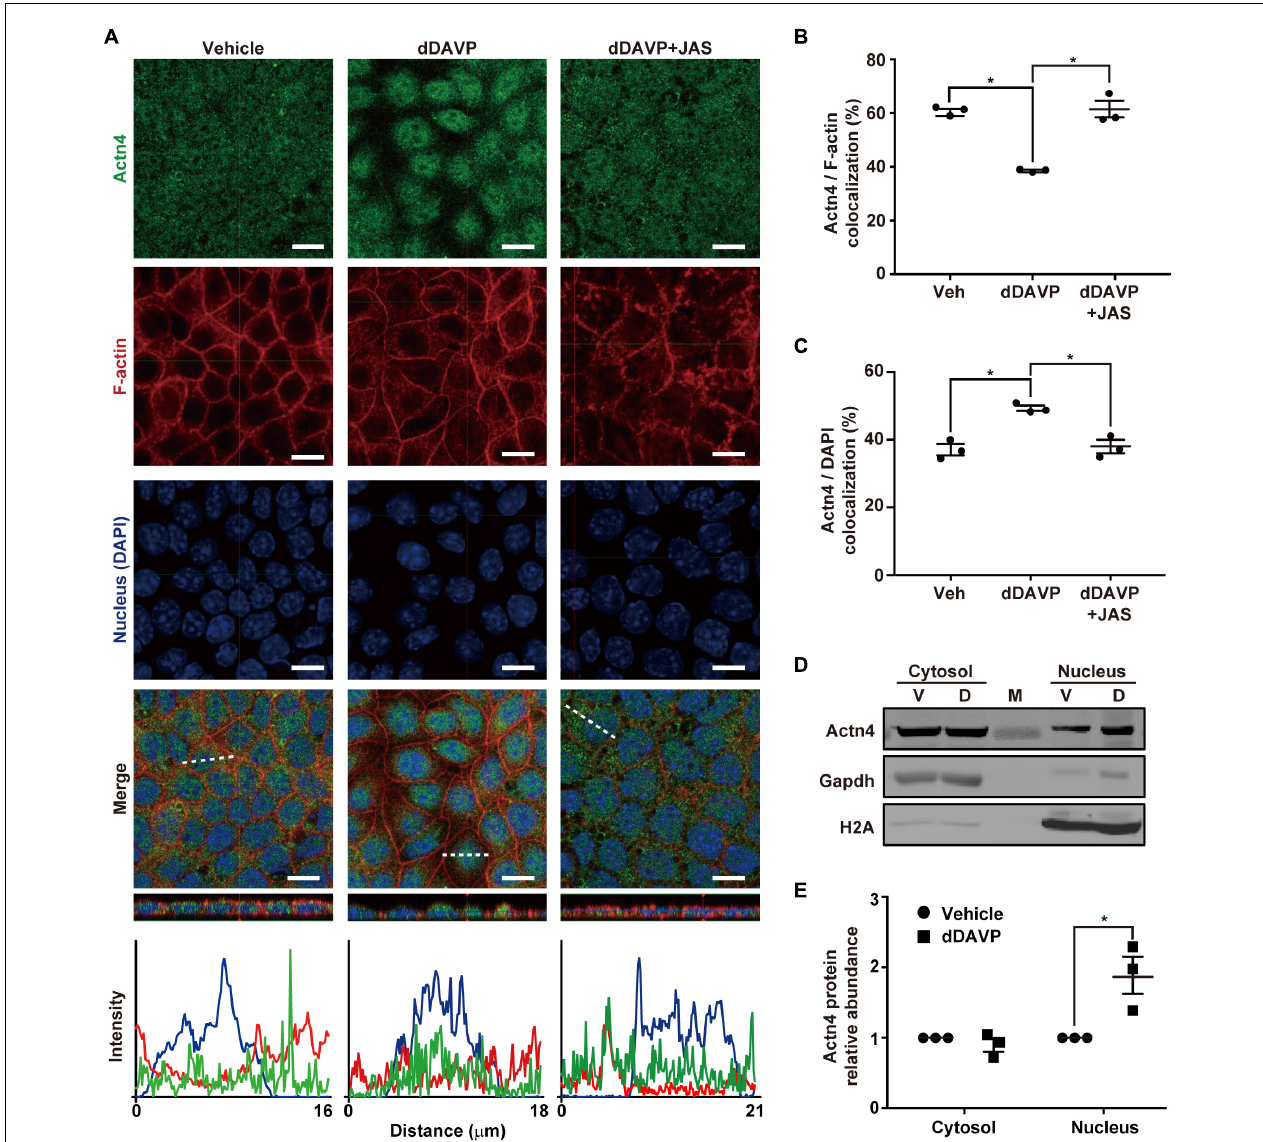
FIGURE 1 | Vasopressin freed α -actinin 4 from F-actin for nuclear translocation in the mpkCCD cells. (A) Confocal immunofluorescence micrographs of α -actinin 4 (Actn4, green) and F-actin (red). Polarized cells grown on Transwell R (cid:13) were exposed (24 h) to vehicle, 1 nM dDAVP, or 1 nM dDAVP plus 50 nM jasplakinolide (JAS) that binds and induces F-actin polymerization (Bubb et al., 2000). The nuclei were stained with DAPI (blue). Shown at the bottoms are signal profiles along the dotted lines. Bars indicate 10 µ m. (B,C) Summaries of Actn4 colocalization with F-actin and DAPI, respectively. Numbers are means ± SEM, summarized from three independent experiments and about 330 cells per experiment. Asterisks indicate statistical significance, t -test p < 0.05. (D,E) Representative immunoblotting and summary of Actn4 in the cytosol vs. nuclei of the cells exposed to vehicle (V) vs. dDAVP (D). Numbers are means ± SEM, summarized from three independent experiments. Gapdh and H2A were markers for cytosol and nuclei, respectively. Protein intensities were corrected against those of Gapdh or H2A to avoid variations in the sample preparation. M,